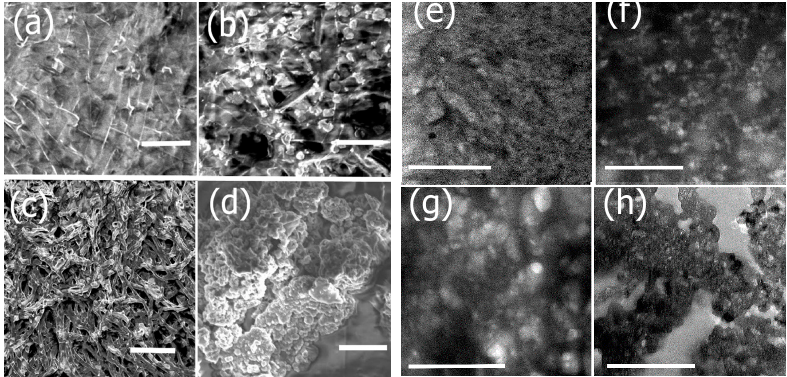
Figure 4. SEM and TEM images showing morphology changes after functionalization with each component. ( a ) SEM image of nanoribbons functionalized with laminin (scale bar = 2 μ m); ( b ) SEM image showing subsequent conjugation with Artemin (scale bar = 2 μ m); ( c ) SEM image after incorporation of Type IV collagen to laminin-artemin-bound nanoribbons (scale bar = 5 μ m); ( d ) SEM image after incorporation of PANI to the functionalized biocomposite (scale bar = 5 μ m). ( e ) TEM image of nanoribbons functionalized with laminin (scale bar = 2 μ m); ( f ) TEM image showing subsequent conjugation with Artemin (scale bar = 2 μ m); ( g ) TEM image after incorporation of Type IV collagen to laminin-artemin-bound nanoribbons (scale bar = 3 μ m); ( h ) TEM image after incorporation of PANI to the functionalized biocomposite (scale bar = 3 μ m).